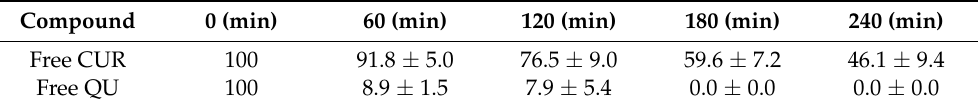
Table 4. Percentage (%) of free CUR and free QU during 240 min in phosphate-buffered saline pH 7.4:PEG400 (90:10) stability study at 37 ◦ C. Results are expressed as mean ± standard deviation.